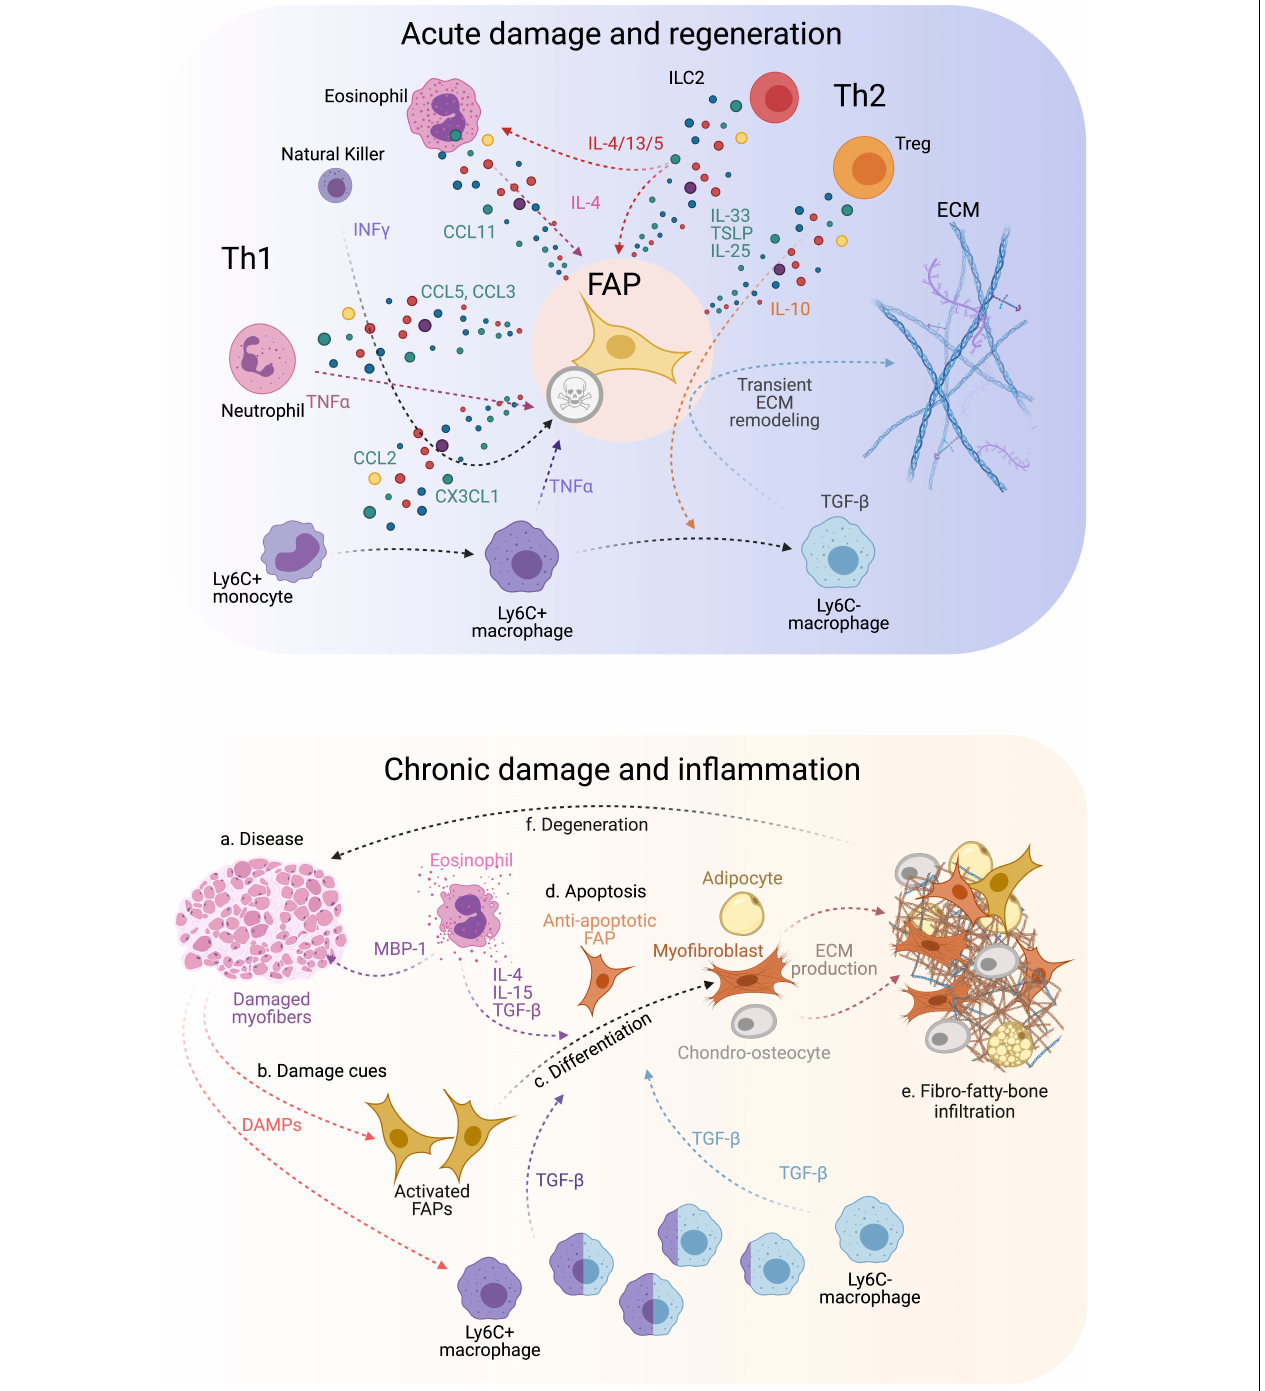
FIGURE 3 | FAP-immune cell cross-talk and secretory flux in regeneration and disease. (Top) FAPs and several immune cell types are involved in regulating efficient muscle regeneration following injury. Th1 and Th2 immune cell populations characterize the immune response. This coordinated FAP-immune cell interaction occurs through the secretion of several pro-regenerative and inflammatory cues from both stromal compartments. All of this facilitates transient ECM remodeling by FAPs that promotes muscle regeneration. (Bottom) On the contrary, neuromuscular disorders and chronic trauma drive the muscle milieu into an aberrant state that usually supports repairing the damaged muscles. Gradually, persistent inflammation tip points the regenerative muscle potential toward muscle degeneration, causes over-activation of FAPs, increases TGF- β levels beyond a regenerative state, and leads to FAP-mediated tissue replacement by fibrous, fat and bone-like tissues. Owing to this, affected muscles reach a state of pathogenic positive feedback loop where damage-driven fibro-fatty-bone infiltration enhances tissue malfunctioning and failure.